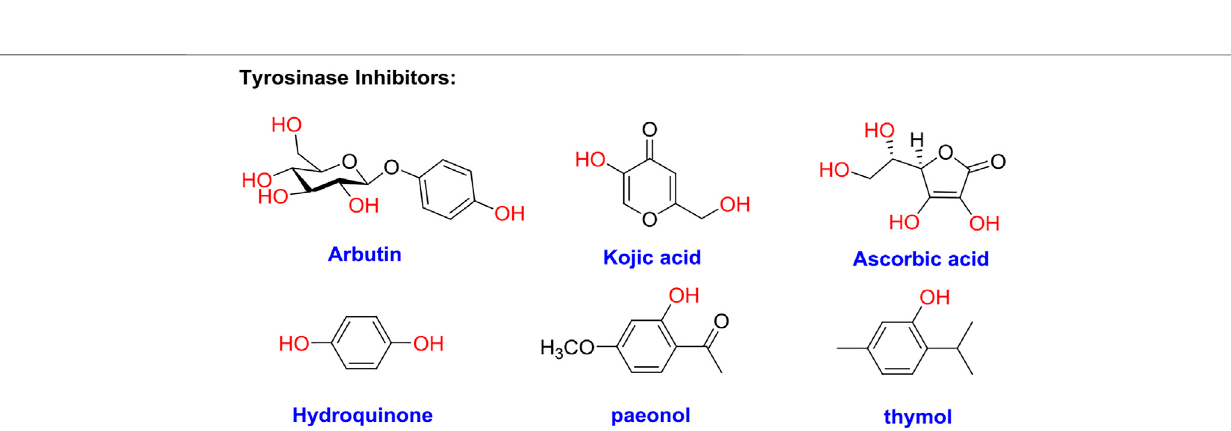
FIGURE 1 | Plots of ν vs. [E] and the Lineweavere – Burk plot of compound A12 (concentrations: (a) 0, (b) 0.75, (c) 1 μ M, and (d) 1.5 μ M).